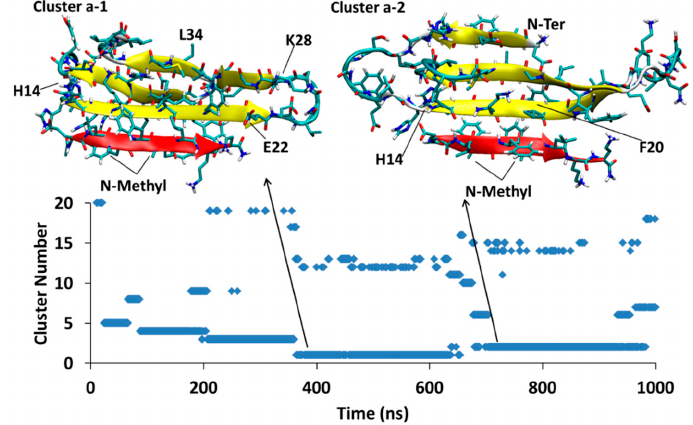
Figure 8. A β 42T -SGD1-a: represented the two most populated clusters; cluster Da1 and cluster Da2 in the trajectory.